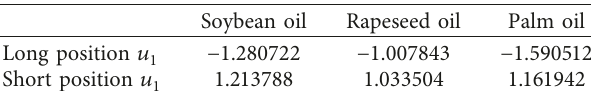
Table 9: VaR m estimation